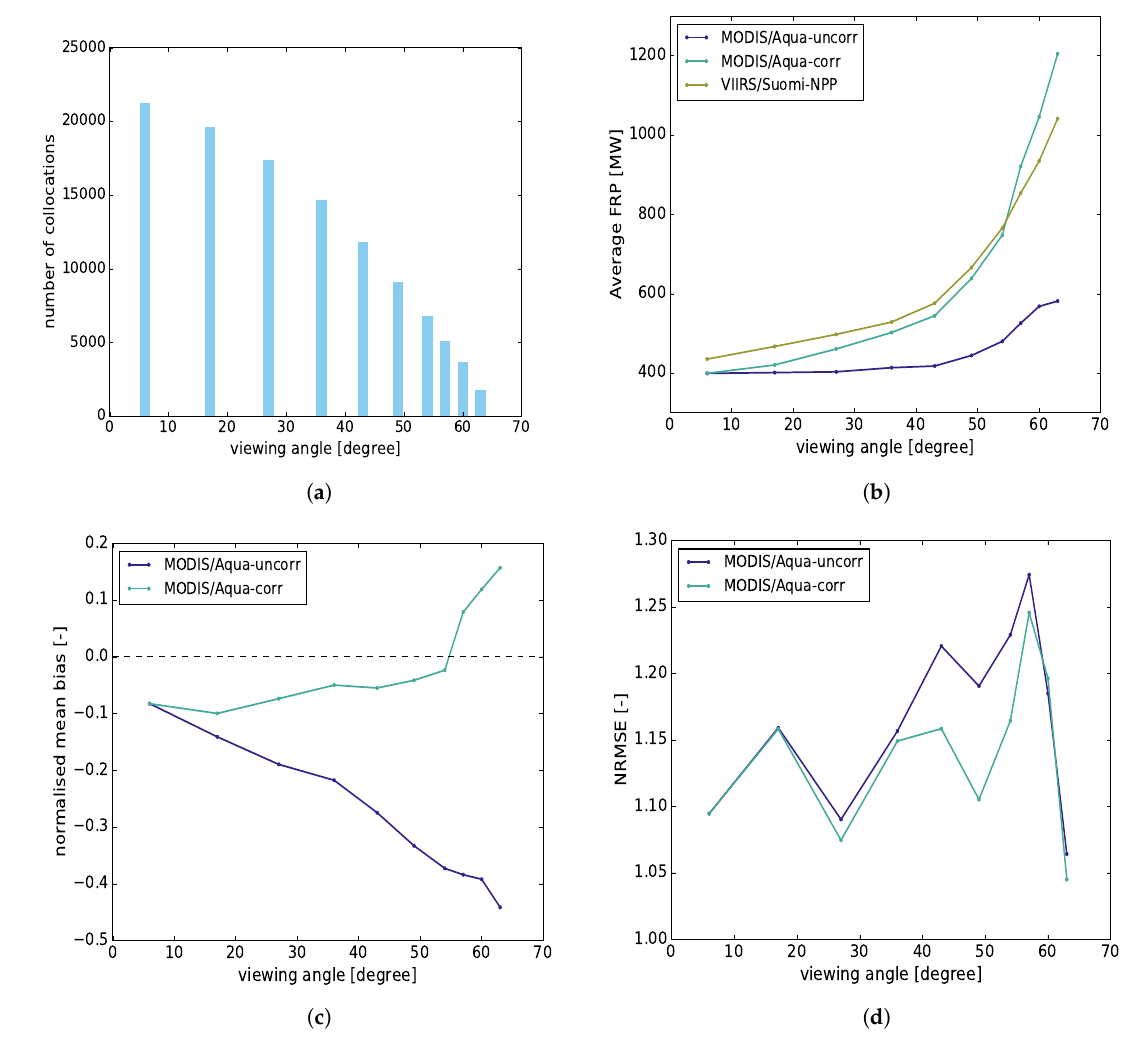
Figure 4. Statistics of co-located MODIS/Aqua and VIIRS/Suomi National Polar-orbiting Partnership (Suomi-NPP) gridded-FRP observations (hourly, 2017), with and without correction of MODIS observations, classified according to the viewing angle. ( a ) The total number of collocations between MODIS/Aqua and VIIRS/Suomi-NPP; ( b ) the average FRP per grid cell (gridded-FRP) of the co-located pairs; ( c ) the normalised mean bias between the co-located pairs (MODIS-VIIRS); ( d ) the normalised root mean square error (NRMSE) between the co-located